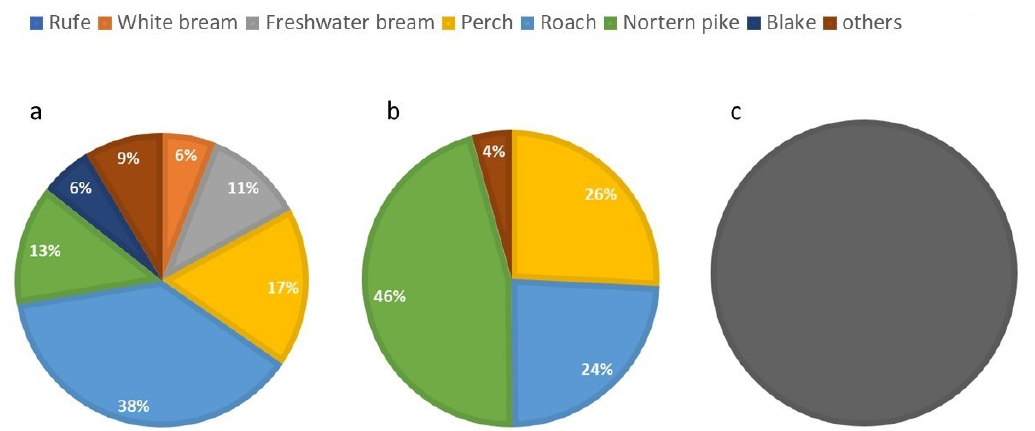
Figure 10. Comparison of the percentage of the main fish species in the weight of the caught fish (( a )—Domysławskie Lake; ( b )—Gardno Lake; ( c )—Stara Kredownia).